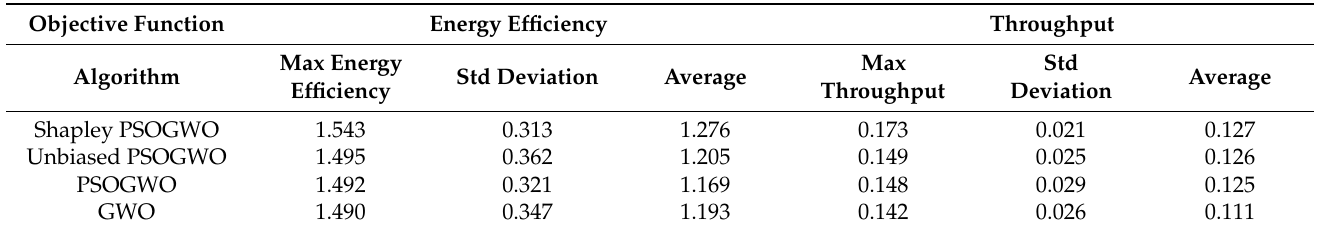
Table 1. Comparison of statistical results of energy efficiency and throughput of EHCRN.